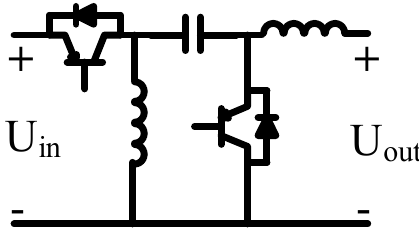
are similar to the Cuk bidirectional DC/DC converter. The topology of the Sepic/zeta bi- directional DC/DC converter is shown in Figure 9.